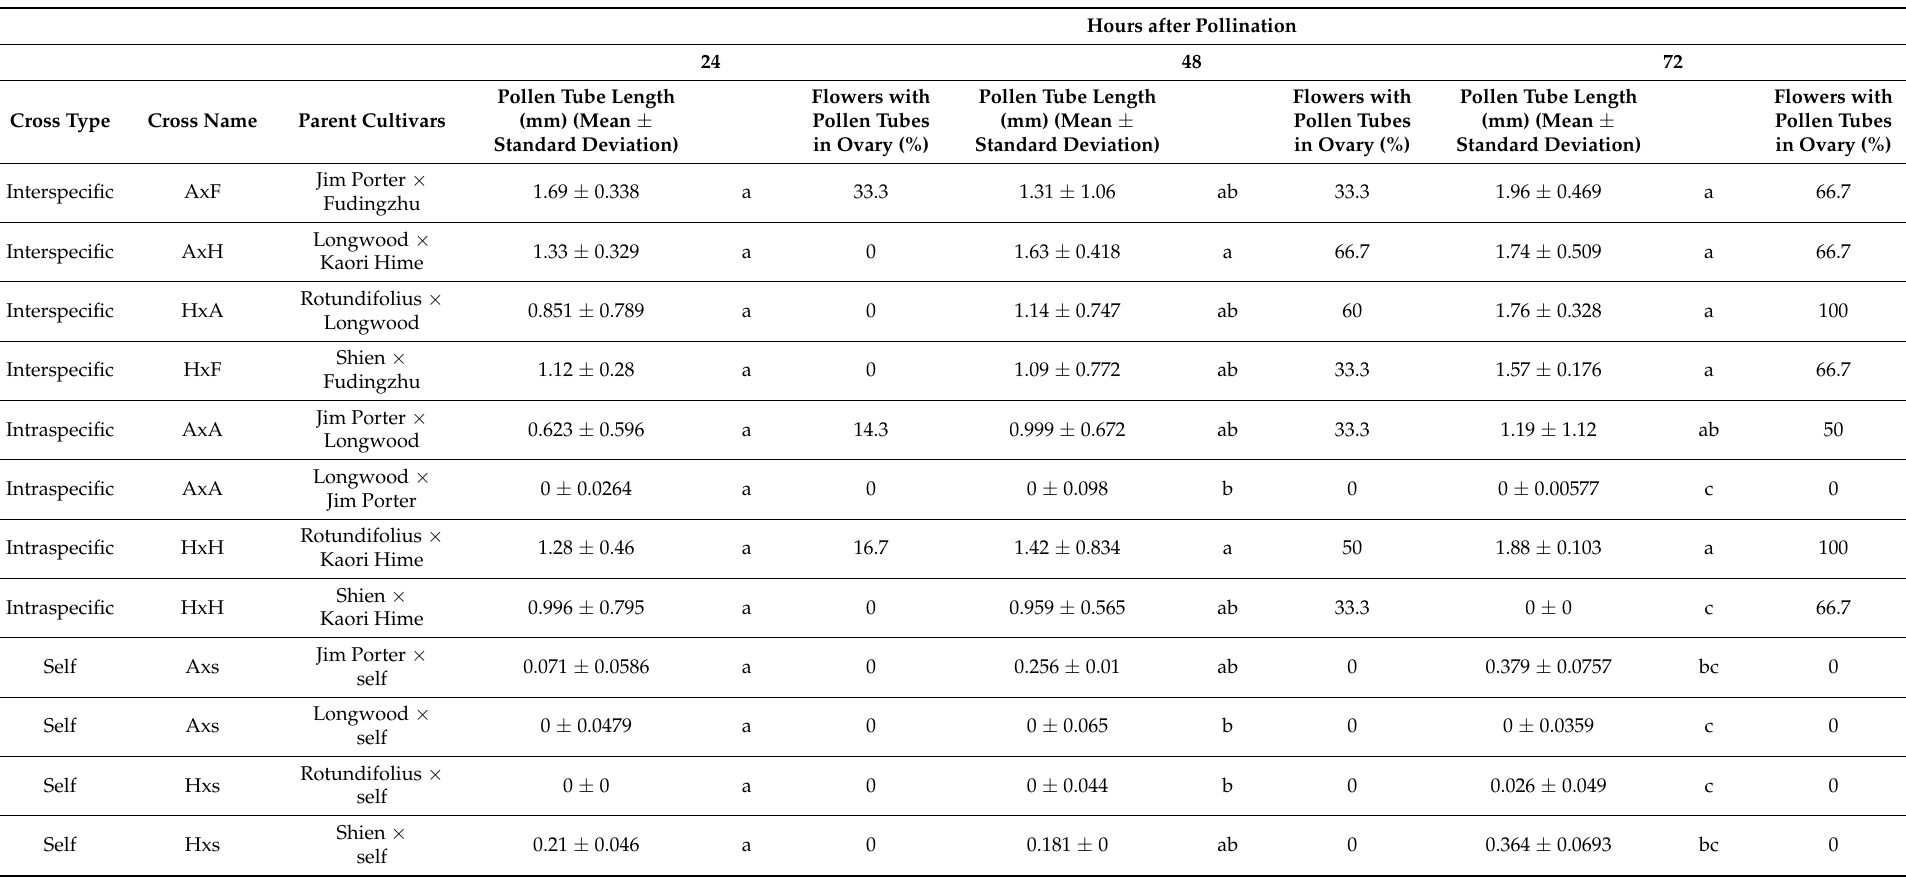
Table 7. Average pollen tube length (mm) and percentage of flowers with pollen tubes reaching the ovary (in italics) for three cross types between Osmanthus species collected 24, 48, or 72 h post-pollination. Abbreviations: A = Osmanthus armatus , F = O. fragrans , H = O. heterophyllus , s = self. The female parent in a cross is listed first. Means followed by the same letter were not significantly different at the α = 0.05 significance